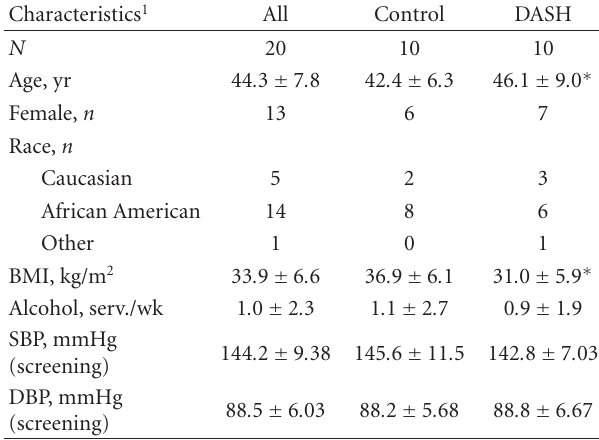
Table 2: Baseline characteristics of study